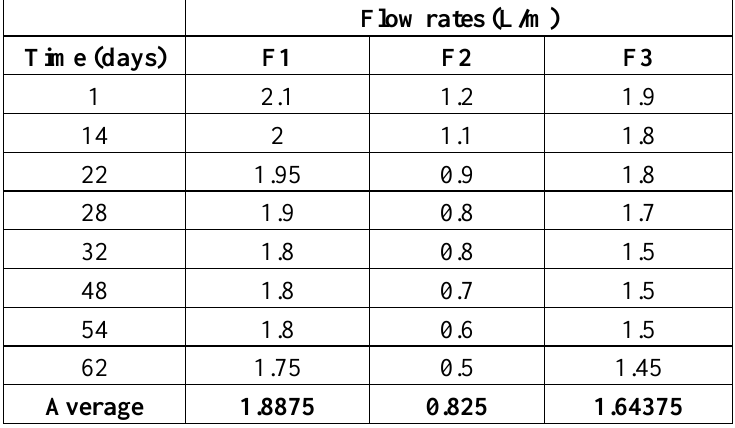
Table 7. Daily Filtration (flow) Rate Upon initial 20 L Charge of Water over the course of the filtration